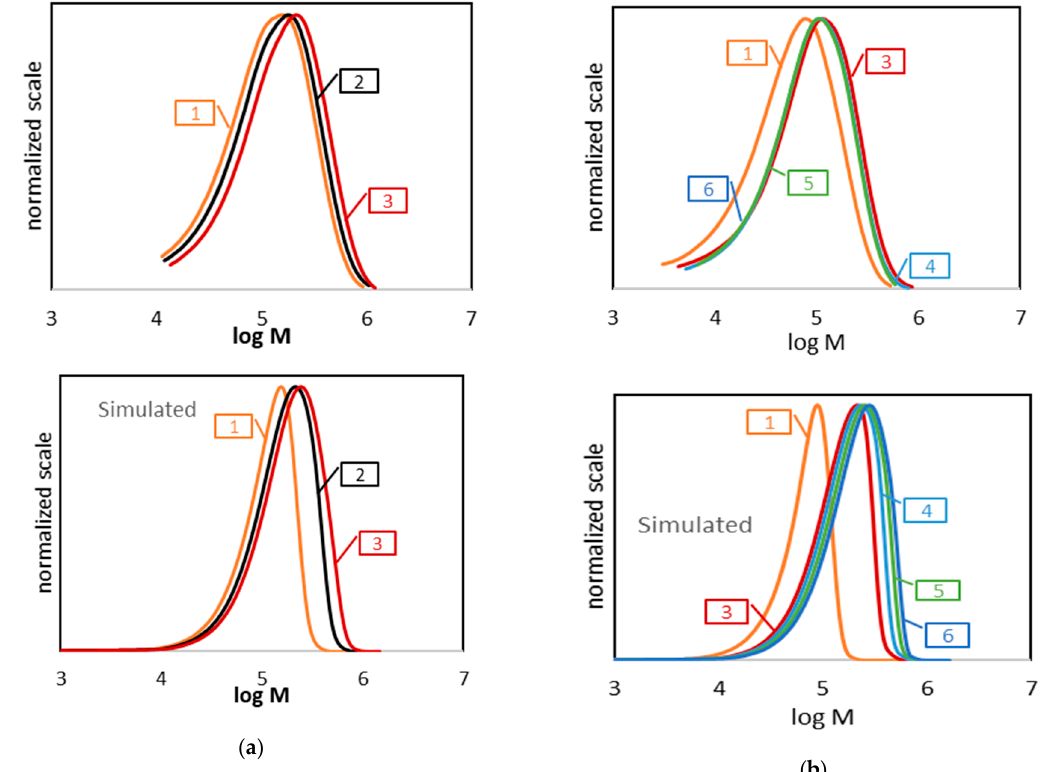
Figure 8. Evolution of molar-mass distributions for polymerizations using DTL1 (experimental and simulated): ( a ) 300:2:1 and ( b ) 300:4:1. Labels: “1” = 30, ”2” = 60, ”3” = 90, ”4” = 120, ”5” = 150, “6” = 180 min.